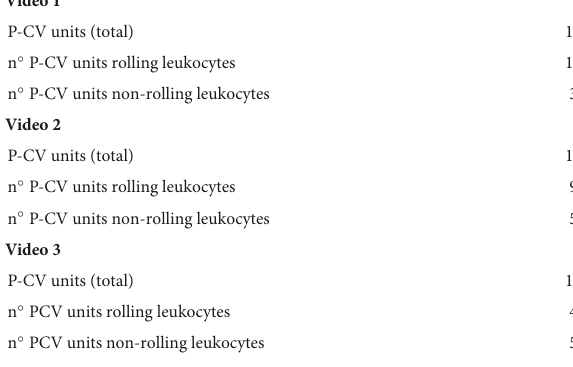
TABLE 1 Table shows numbers of post capillaries venules (PCV) units in each video selected (total) and absolute numbers of rolling leukocytes and non-rolling leukocytes in PCV-units observed counted during 100 frames